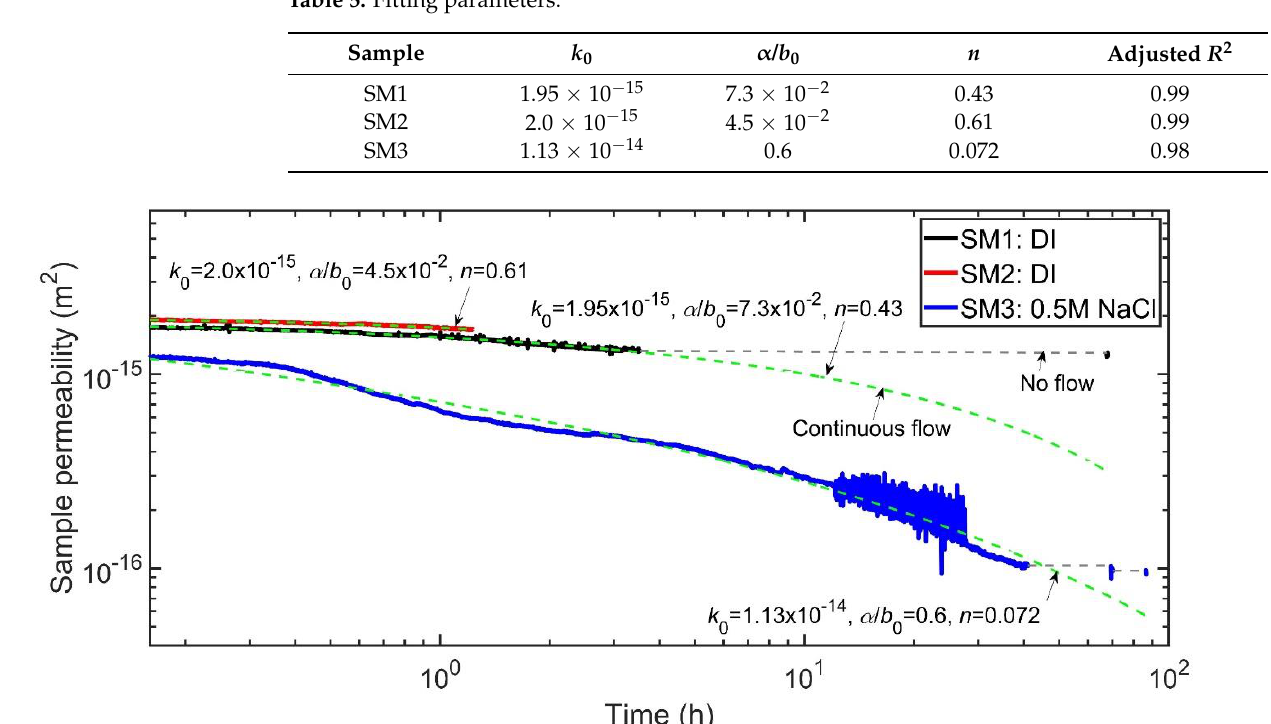
Figure 11. Sample permeability (Equation (1)) variations with time under constant pressure ( P c : 10 MPa and P p : 1 MPa) and room temperature conditions. Fitting curves (in green) are derived based on Equation (10).